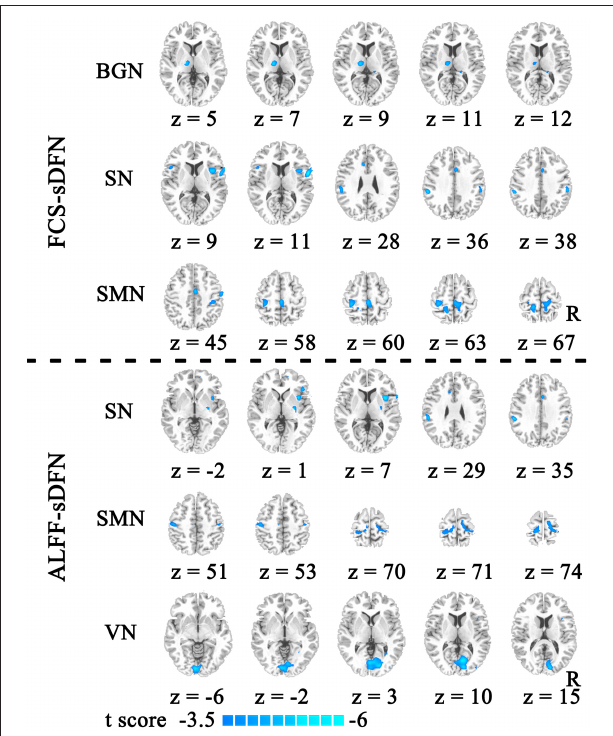
FIGURE 3 | The reduced dynamic functional connectivity (dFC) within the spatial organization of dynamic functional network (sDFN) in schizophrenia. Decreased dFCs within FCS-sDFN were displayed above the dotted line, including the basal ganglia network (BGN), salience network (SN), and sensorimotor network (SMN). Under the dotted line, reduced dynamic functional activity within ALFF-sDFN is shown, including SN, SMN, and visual network (VN). FCS, functional connectivity strength; ALFF, amplitude of low-frequency fluctuations.